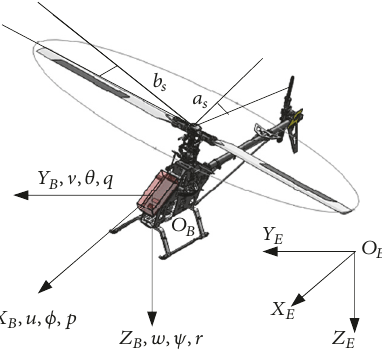
Figure 1: Illustration for helicopter states and coordinates.